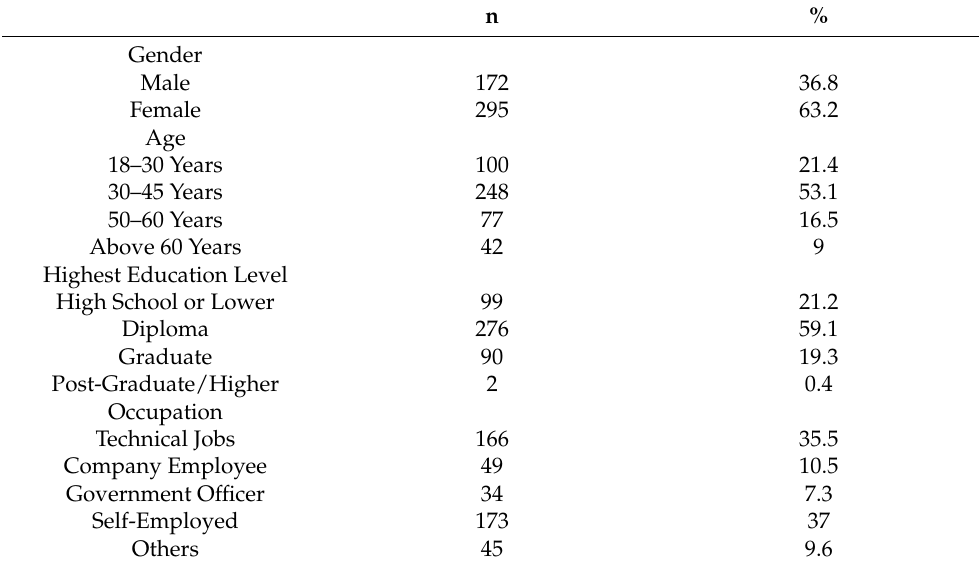
Table 1. Demographics of